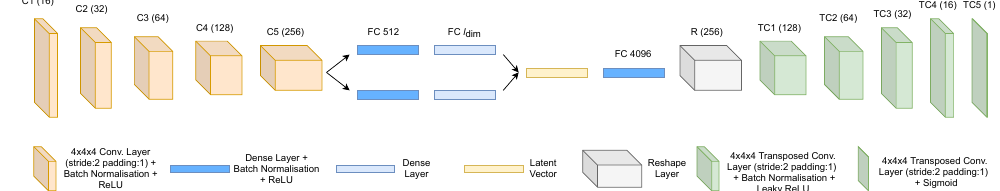
Figure 3. Proposed VAE architecture. As can be seen, the encoder is composed of five convolution blocks (C1 to C5) and two bottleneck dense layers. Each convolution block comprises convolutional layers with an increasing number of filters, with each one followed by a rectified linear unit (ReLU) activation function and batch normalisation [26]. To reduce the size of each feature map by half, 4 × 4 × 4 kernels with a stride of 2 and a padding of 1 were used. To reconstruct the original input, a latent vector with the size of the latent dimension ( l dim ) is passed to a dense layer to, afterwards, be reshaped into 256 activation maps. This is used as input to four transposed convolution blocks (TC1 to TC4), each one composed of a 4 × 4 × 4 transposed convolutional layer, with a decreasing number of filters with a stride of 2 and a padding of 1, followed by a Leaky ReLU activation (with a negative slope of 0.2) and batch normalisation. The last transposed convolutional layer (TC5) is followed by a sigmoid activation function to ensure that all output pixel values belong to the original range of values [ 0,1 ]